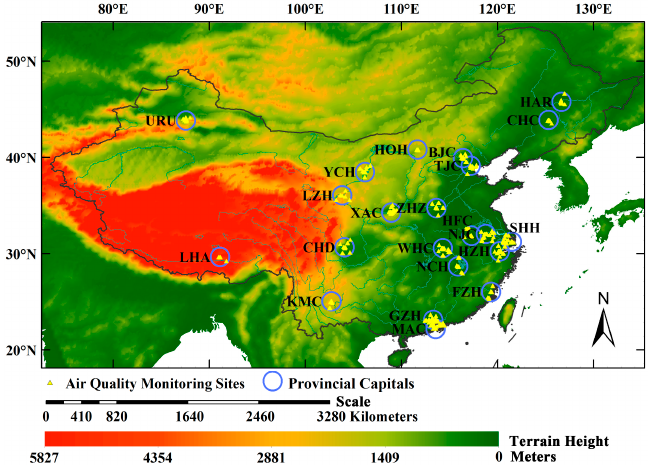
Figure 1. Geographic distribution of monitoring sites within the scope of each provincial capital. The provincial capitals include Lhasa (LHA), Urumqi (URU), Hohhot (HOH), Yinchuan (YCH), Lanzhou (LZH), Harbin (HAR), Changchun (CHC), Beijing (BJC), Tianjin (TJC), Hefei (HFC), Zhengzhou (ZHZ), Wuhan (WHC), Nanjing (NJC), Nanchang (NCH), Xi’an (XAC), Shanghai (SHH), Fuzhou (FZH), Guangzhou (GZH), Hangzhou (HZH), Macao (MAC), Chengdu (CHD) and Kunming (KMC).